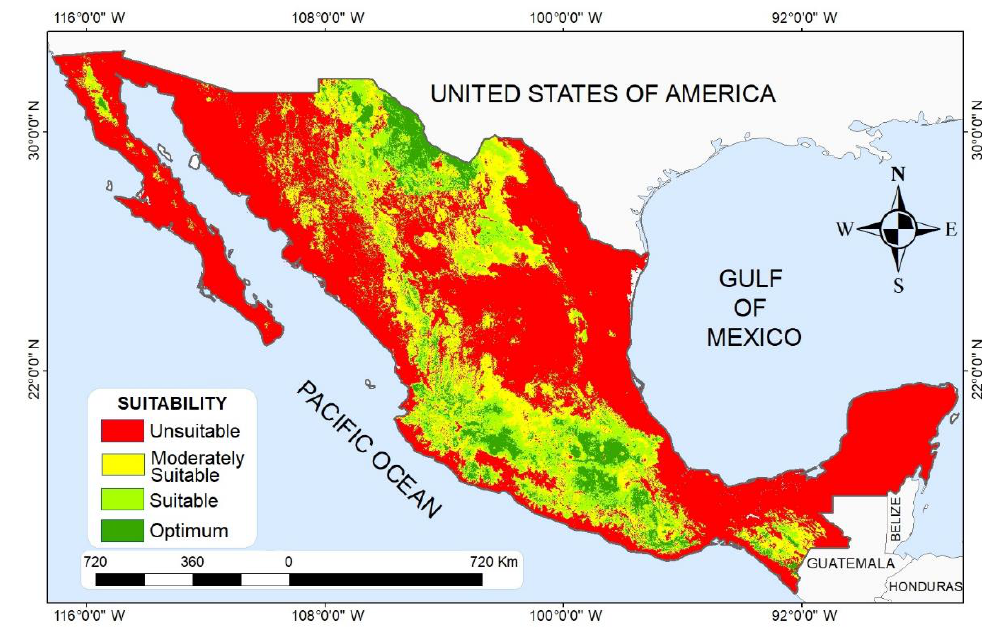
Figure 2. Areas of fig crop suitability for current climate. 3.1. Habitat Suitability Modeling under Climate Change Effects (RCP 2.6 and 8.5) The values obtained from the standard ROC AUC test for the HADGEM2-ES and MPI-ESM-LR global circulation models for the periods 2050 and 2070 were 0.918 to 0.924 for model training and 0.831 to 0.981 for validation (Figures 3a–d and 4a–d). The partial ROC values for both general circulation models and the two RCP 4.5 and 8.5 scenarios were between 1.81 and 1.83, in all cases significant ( p < 0.01).